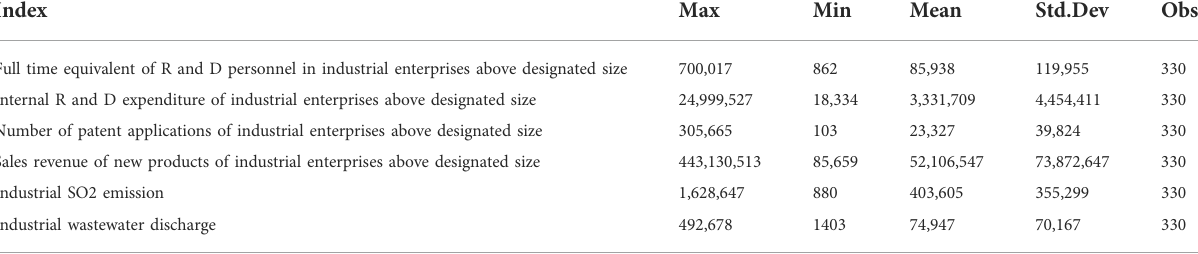
TABLE 2 Descriptive statistics of input and output indicators.